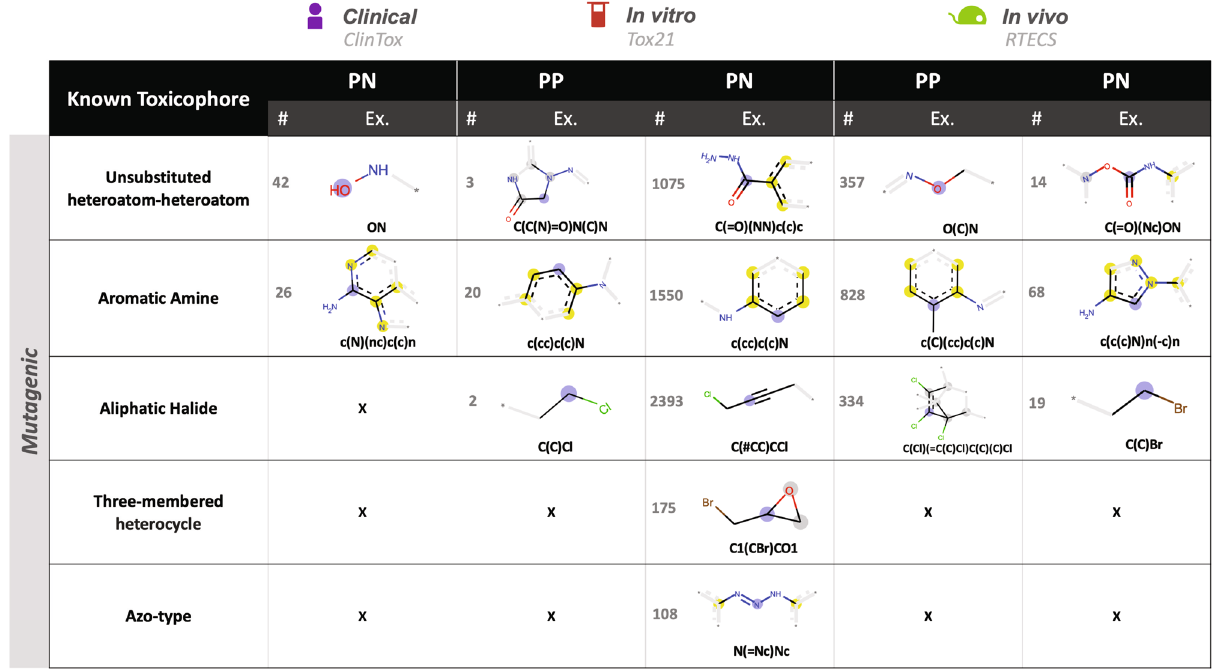
Figure 7. Matched toxicophores. Top three (ClinTox, RTECS) or top five (Tox21) matched known toxicophores to toxicophores collected from the CEM as PP of toxic molecules and PN of nontoxic molecules. For Tox21, the top five most frequent matches were examined due to the large number of matches. Three types of known toxicophores were matched: experimental and computational mutagenic toxicophores, and reactive substructures commonly used to filter molecules. The table provides the number (#) of matches, and specific examples (Ex.). Only mutagenic toxicophores are displayed in table, full list is given in Supplementary Fig.